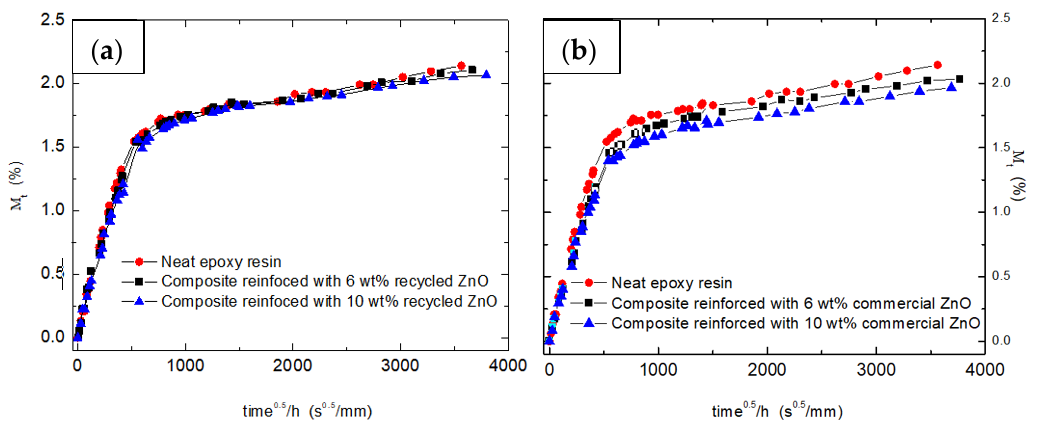
Figure 3. Absorption curves for neat epoxy thermoset and epoxy nanocomposites reinforced with recycled ( a ) and commercial ( b ) ZnO particles.